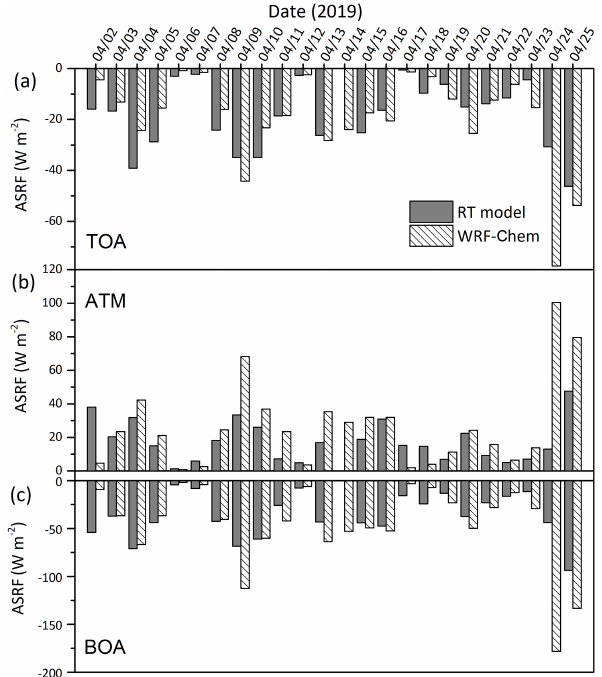
Figure 13. Comparisons of daily mean ASRF between the RT model calculations and the WRF-Chem simulations during the DAO-K campaign: (a) TOA, (b) ATM, and (c) BOA.